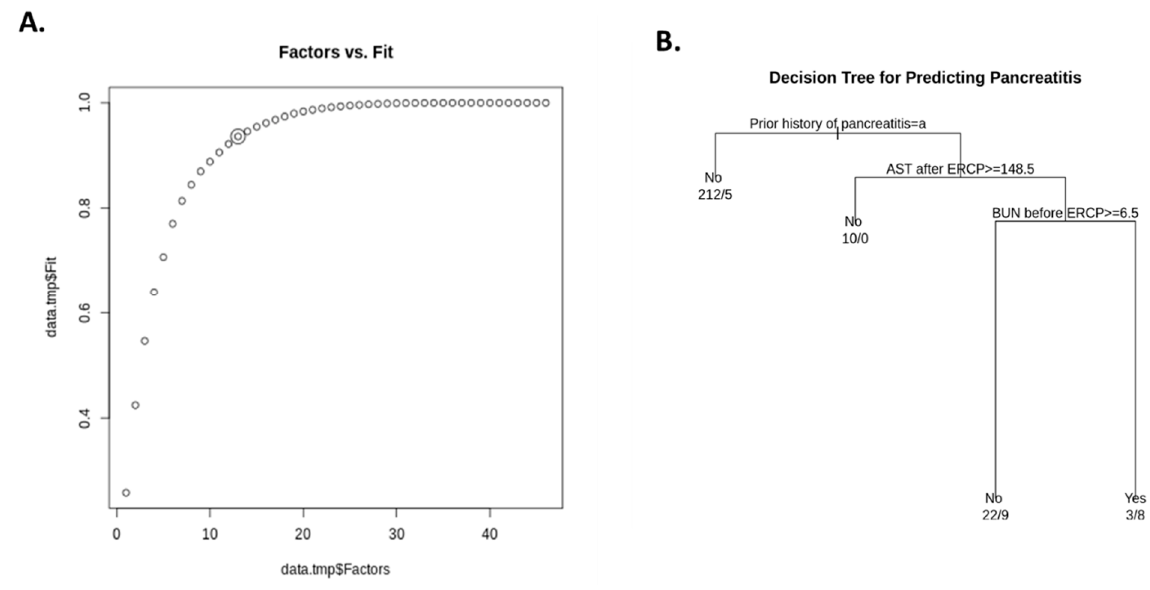
Figure 2. Elbow method extraction. The best factor (14) was extracted using the elbow method based on change in fit ( A ). ( B ) shows the clinical “decision tree” for predicting post-ERCP pancreatitis, which was created using Classification and Regression Trees (CART); major discriminative factors included prior history of ERCP, followed by AST after ERCP and BUN before ERCP.